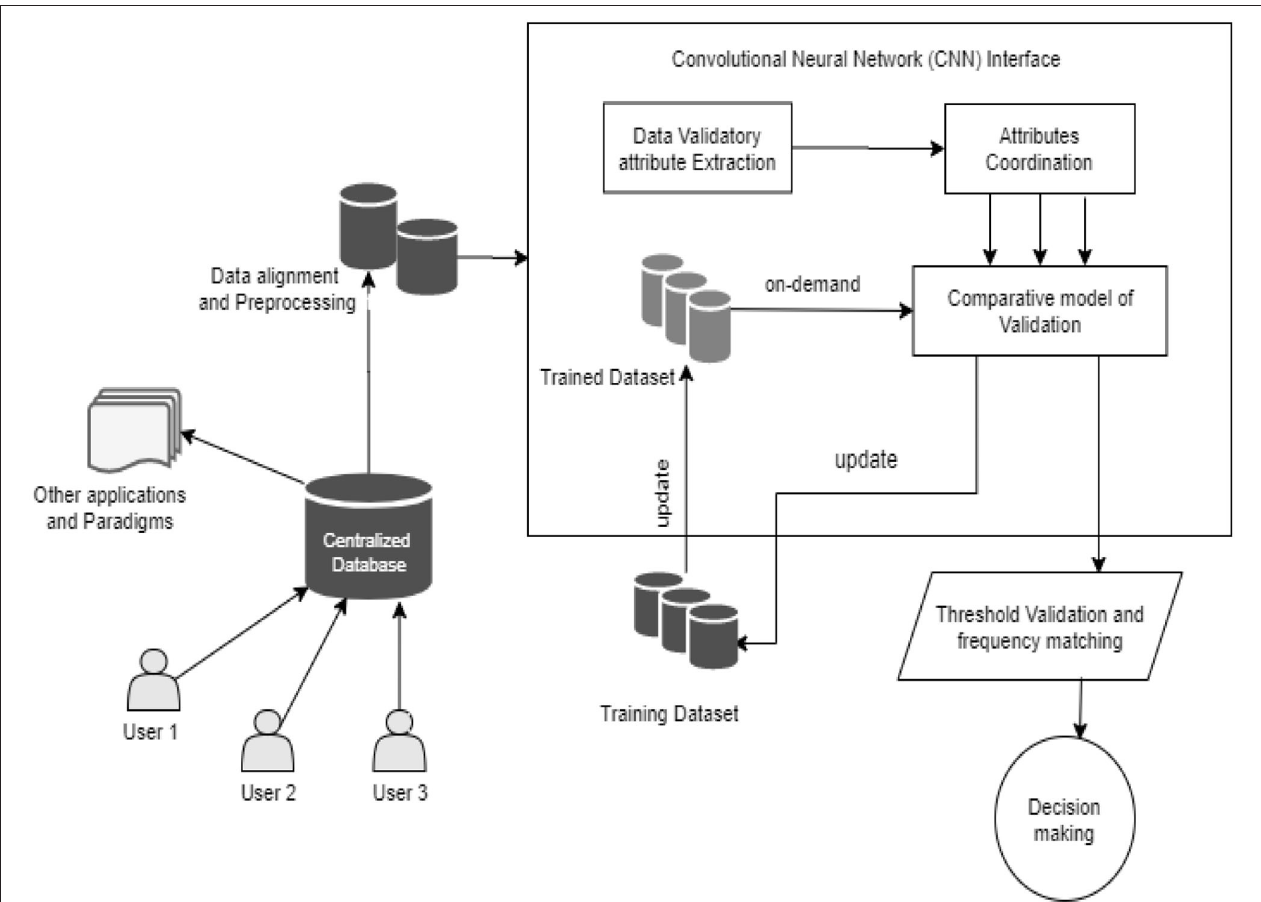
FIGURE 1 | Architectural diagram of the proposed technique toward decision making in speech